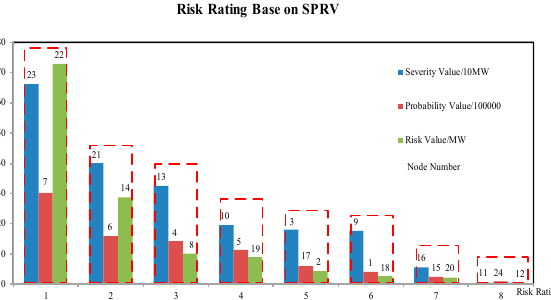
Figure 7. Diagram of the risk rating based on the severity probability risk valuation (SPRV) in the RTS-79 system.